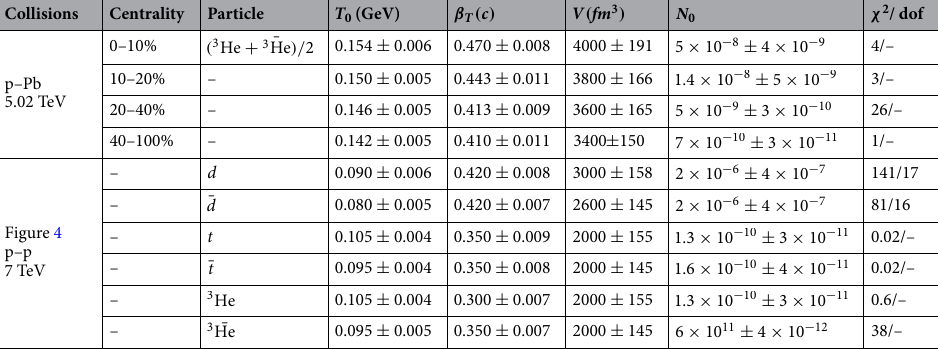
Figure 2. Transverse momentum spectra of d , intervals in Pb–Pb collisions at 5.02 TeV. The symbols represent the experimental data measured by the ALICE Collaboration 57 , while the curves are our fitted results by using BGBW statistics, Eq. (1). Each panel is followed by the ratio of the